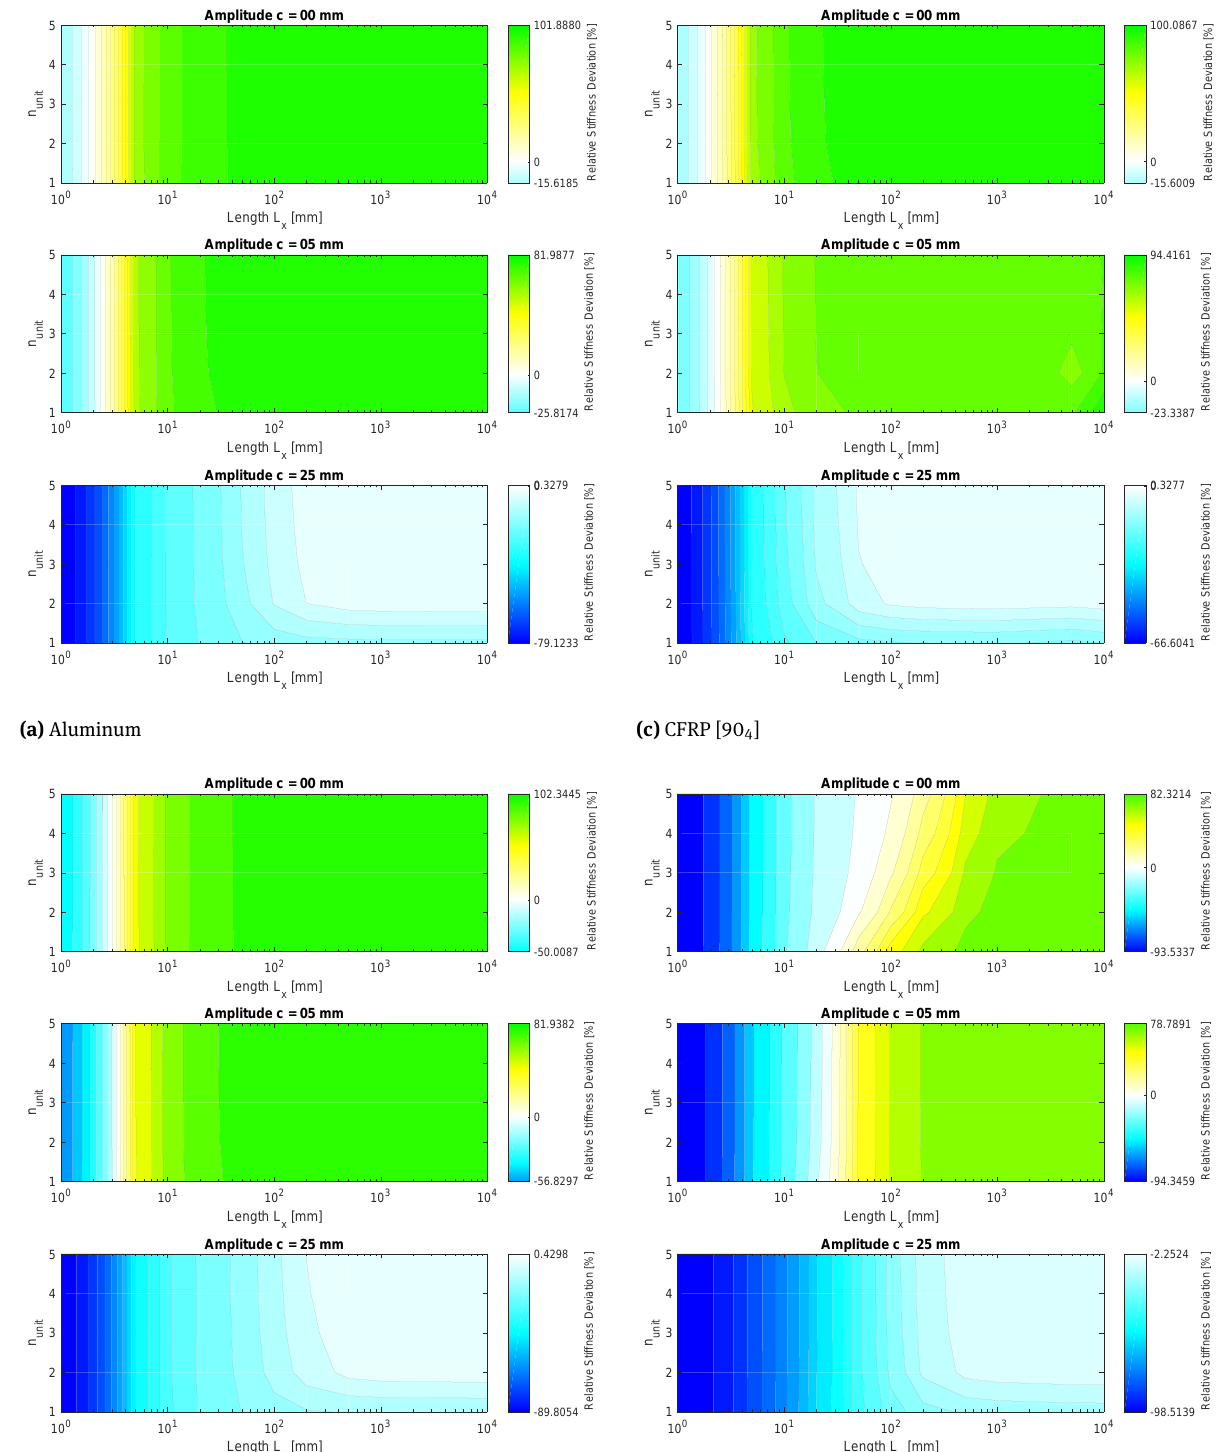
Figure 21: Load case 6 normalized apparent stiffnesses versus L x and n unit - for Aluminum and CFRP [0 4 ]